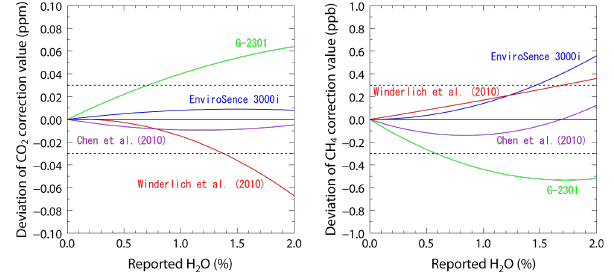
Figure 7. Comparison of water correction functions for CO 2 and CH 4 . The solid lines indicate difference in calculated water correction values for the individual instrument-specific water correction function from those of G-1301 as a function of reported water vapor concentration. Blue: EnviroSence 3000i; green: G-2301; purple: G-1301-m from Chen et al. (2010); red: EnviroSence 3000i from Winderlich et al. (2010). The dashed lines indicate typical analytical precision of WS-CRDS instrument (±0.03 ppm for CO 2 , ±0.3 ppb for CH 4 ).